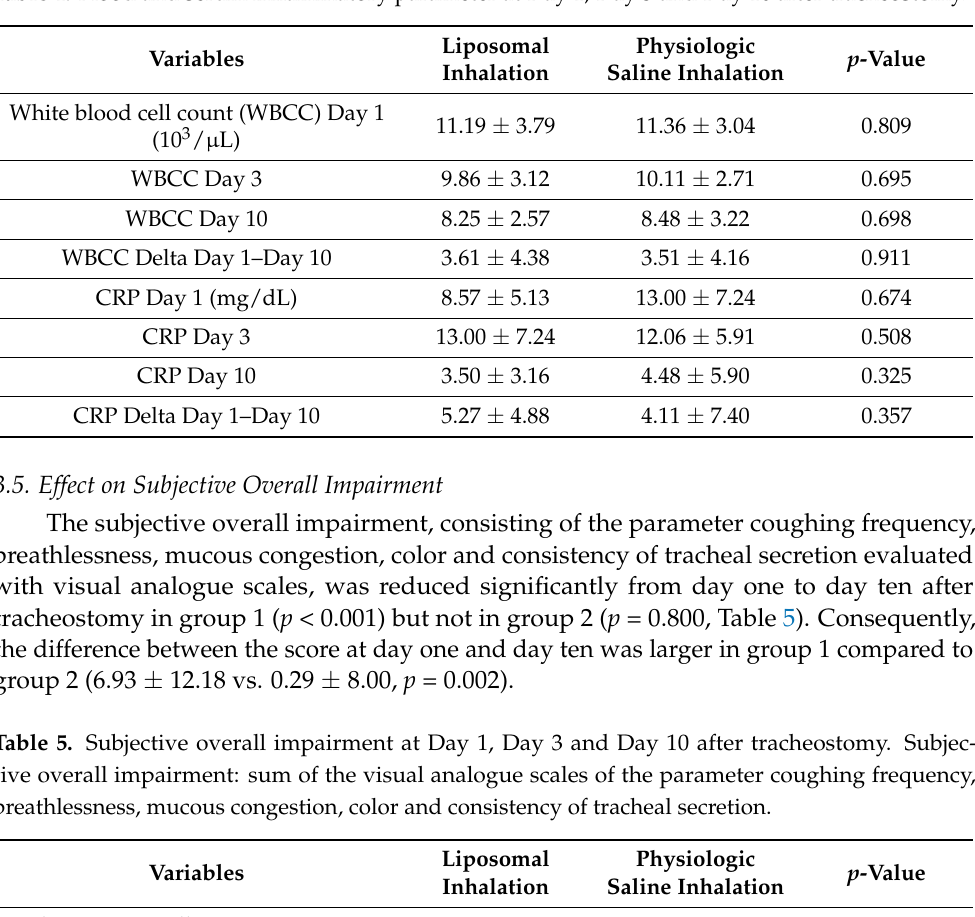
Table 4. Blood and serum inflammatory parameter at Day 1, Day 3 and Day 10 after tracheostomy.